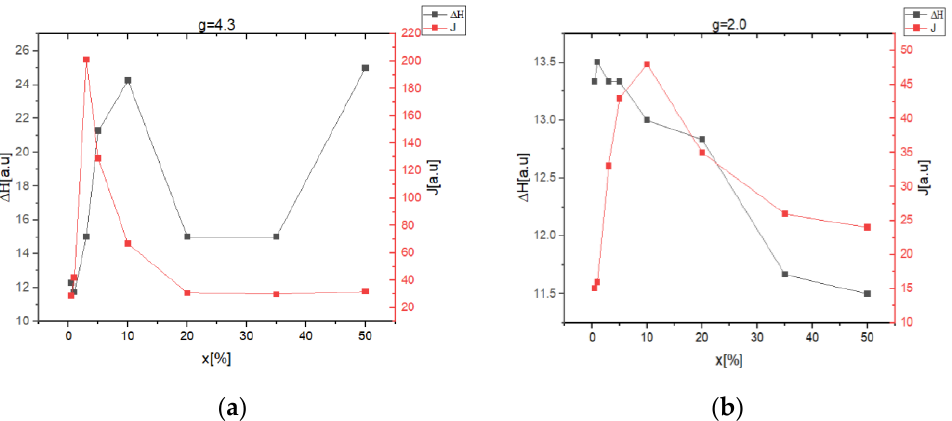
Figure 3. Correlation between intensity (J) of resonance line and the line- width (ΔH) for x(Fe 2 O 3 ∙V 2 O 5 )∙(100 − x)[P 2 O 5 ∙CaO]glass systems: ( a ) g~4.3, ( b )